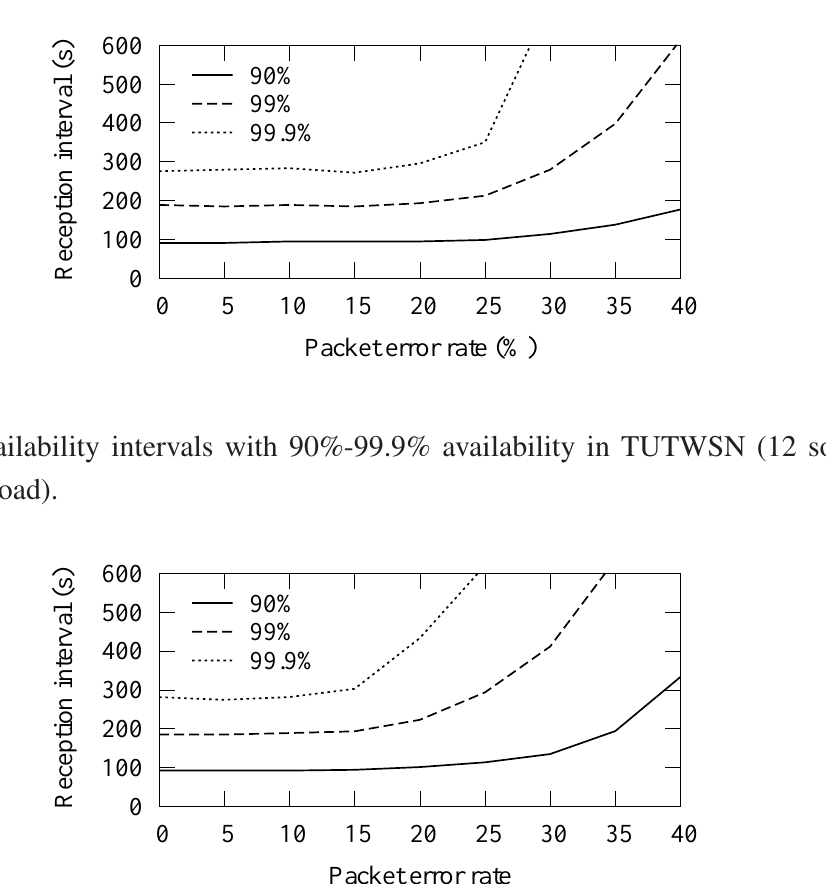
Figure 14. Availability intervals with 90%-99.9% availability in ZigBee (12 sources, 5.5 B/s offered load).